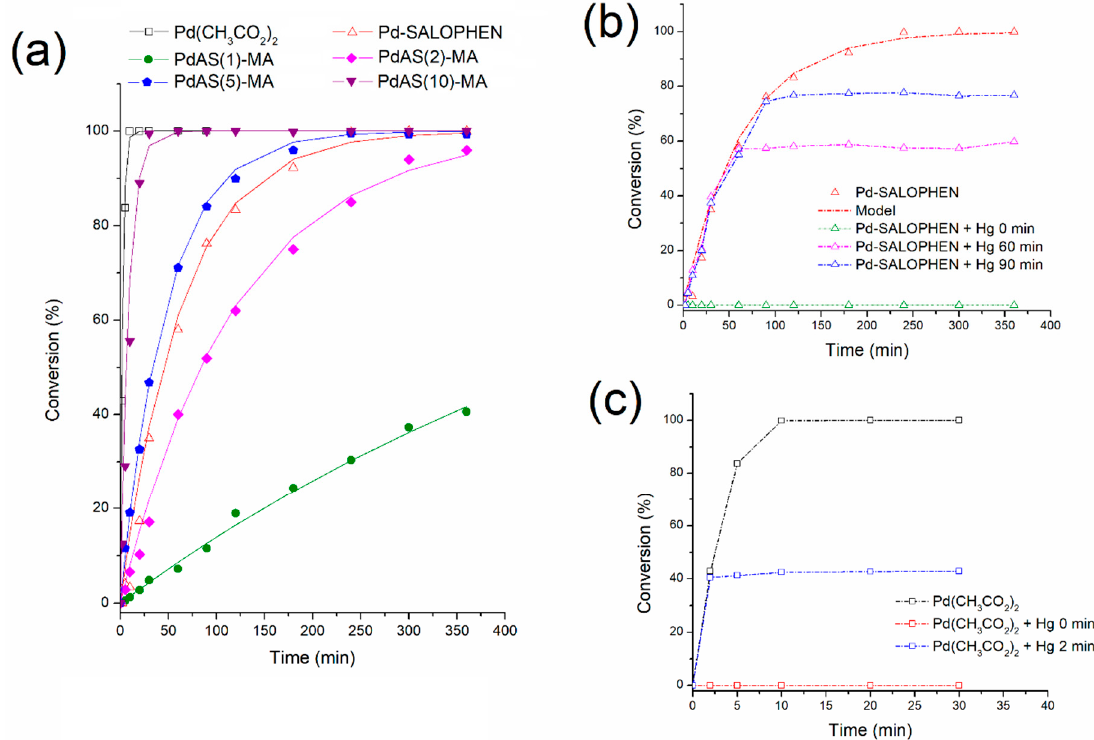
Figure 7. Kinetic profiles for the coupling of I-Ph with methyl acrylate to produce methyl cinnamate (MCIN) using the Pd-based catalysts. ( a ) Open square: Pd(CH 3 CO 2 ) 2 ; open triangle: Pd-SALOPHEN, fill circle: PdAS(1)-MA, fill diamond: PdAS(2)-MA, fill pentagon: PdAS(5)-MA, and fill inverse triangle: PdAS(10)-MA. ( b ) Hg(0) poisoning test for Pd-SALOPHEN catalyst and ( c ) Hg(0) poisoning test for Pd(CH 3 CO 2 ) 2 catalyst.